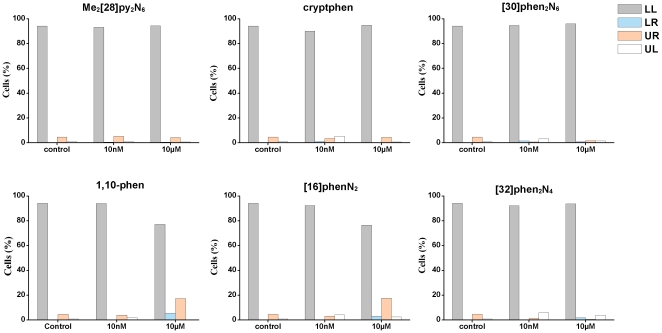
Relative percentages of viable cells (LL), early apoptotic cells (LR), necrotic cells (UL) and late apoptotic cells (UR) induced by Me2[28]py2N6, [32]phen2N4, cryptphen, [16]phenN2, [30]phen2N6 and 1,10-phen in MCF-7 cells.The cells have been treated with concentrations 10 nM and 10 µM of each compound for 48 h and comparing with the control.